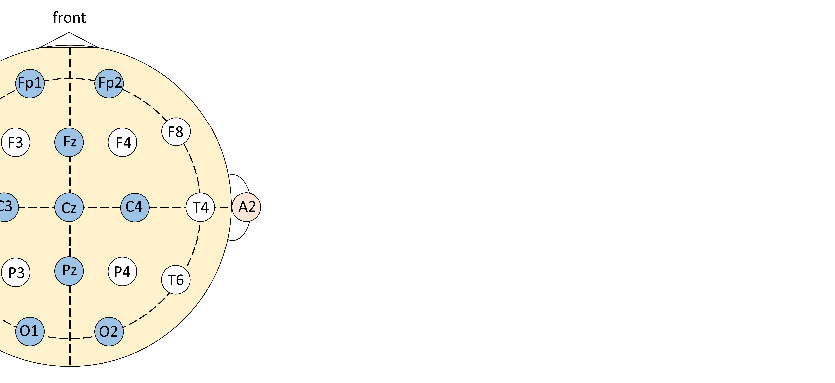
Figure 2. International 10 – 20 system, with the codes corresponding to brain positions: Fp for the frontal polar area, F for the frontal area, C for the central area, P for the parietal area, O for occipital, T for the temporal area, A the for the auricular area.